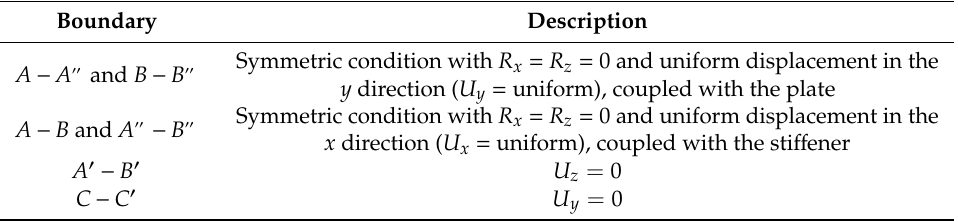
Figure 2. 1 / 2 + 1 / 2 span sti ff ened plate model. Figure 2. 1/2 + 1/2 span stiffened plate model. Table 2. Boundary conditions for the 1 / 2 + 1 / 2 span Table 2. Boundary conditions for the 1/2+1/2 span model.